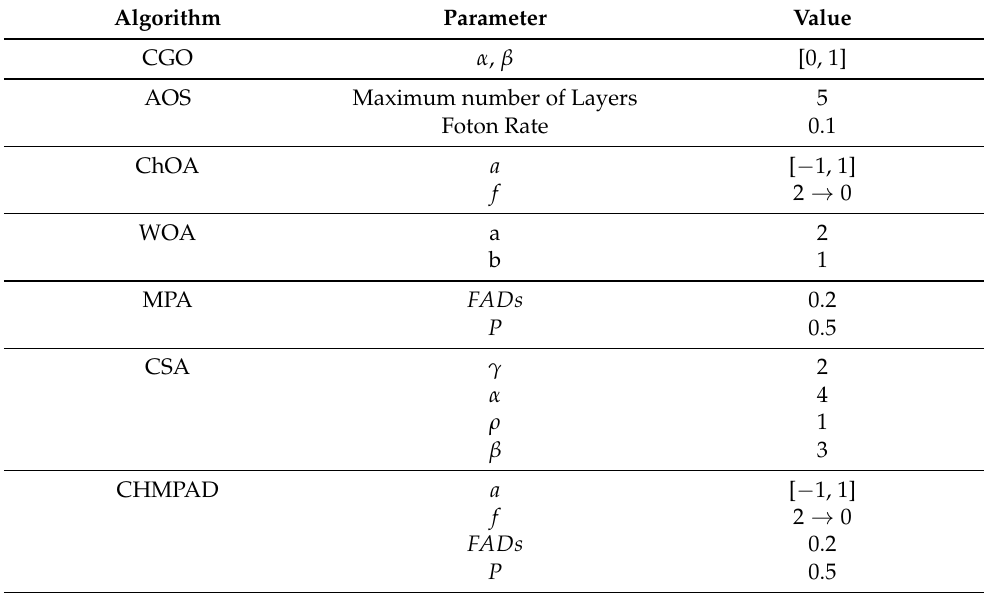
Table 2. Parametric details of the comparison